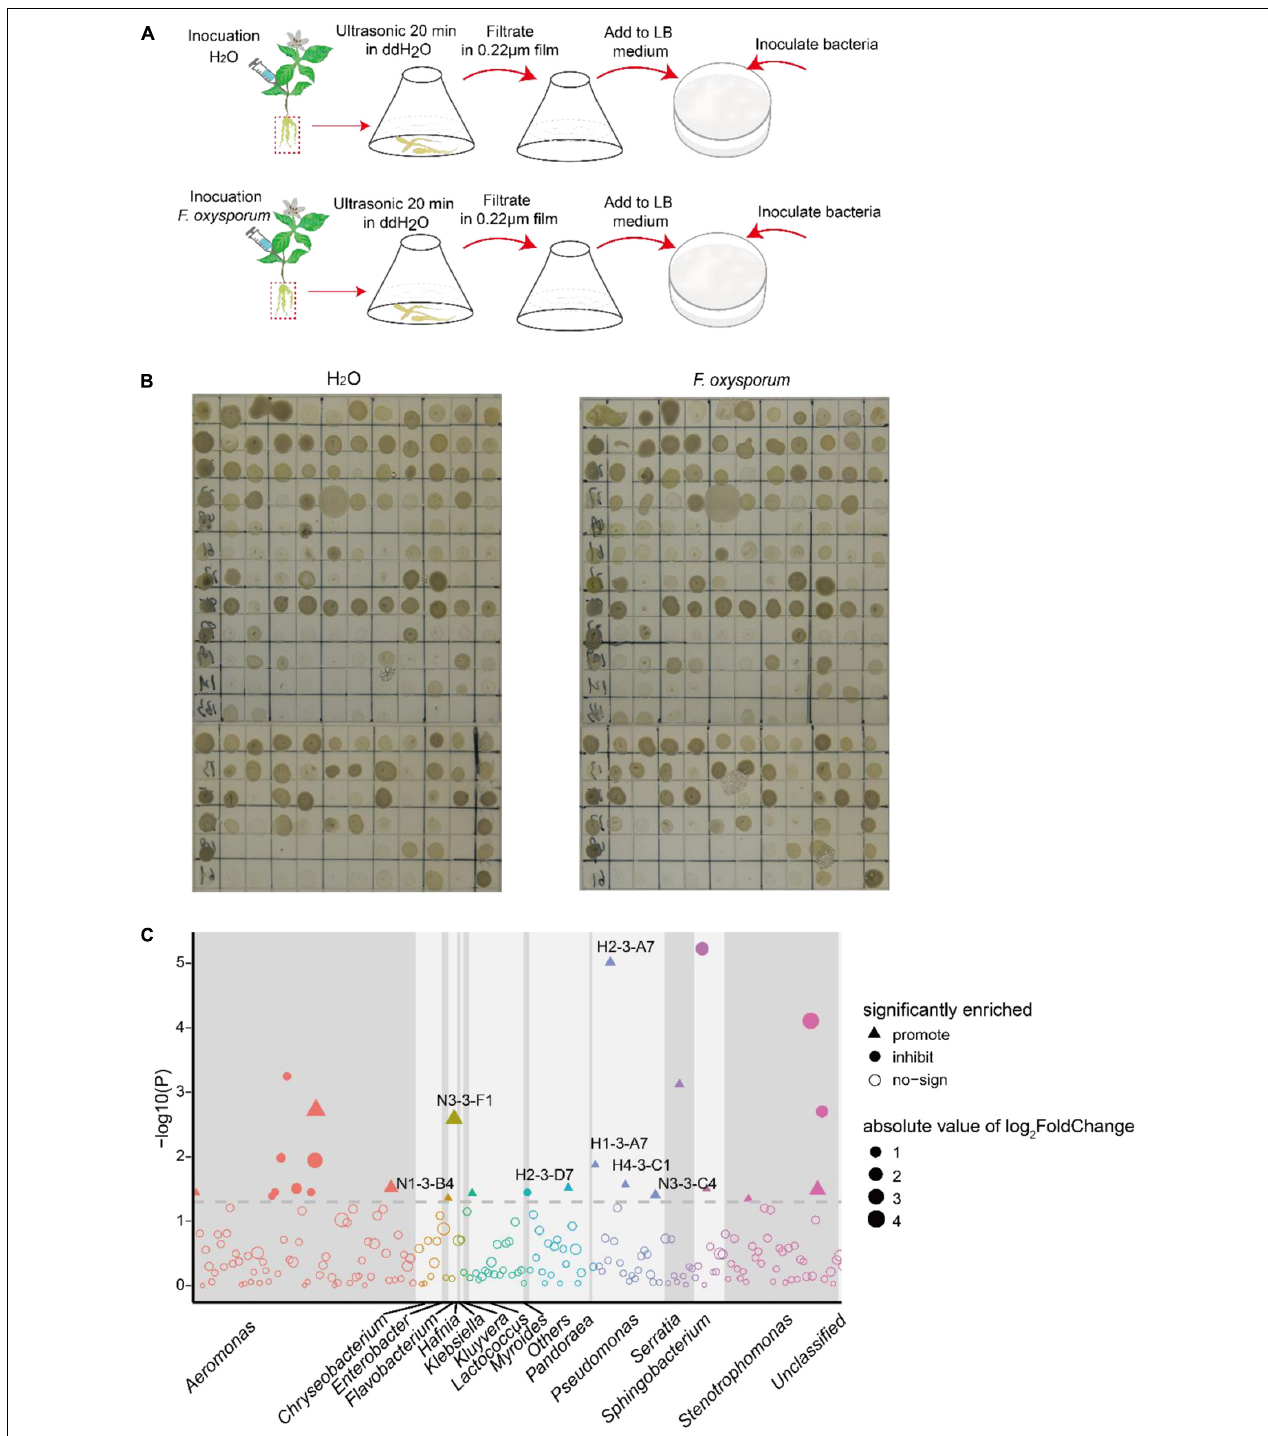
FIGURE 5 | The extracts of the tuberous root of P. heterophylla inoculated with F. oxysporum affect the growth of isolates. (A) We ground the tuberous roots of P. heterophylla infected with P. oxysporum into powder, added 50 ml of water, and ultrasonicated the solution for 20 min; inoculation with H 2 O served as a control. The suspension was sterilized with a 0.22- µ m membrane and then added to LB medium according to the volume ratio of 1:100. Next, 1 µ l of cultures of 216 bacterial strains isolated from diseased tuberous roots were inoculated in LB medium with aqueous extract and cultured in an incubator at 25 ◦ C with light. After 2 days of cultivation, compared with the control, the (B) growth phenotype diagram and (C) the Manhattan map show the effects on isolates in aqueous extracts. The dashed line represents the logarithm of P = 0.05, and triangles and circles represent the effects of promotion and inhibition, respectively. Different colors and sizes represent different taxa of isolates and the absolute value of log 2